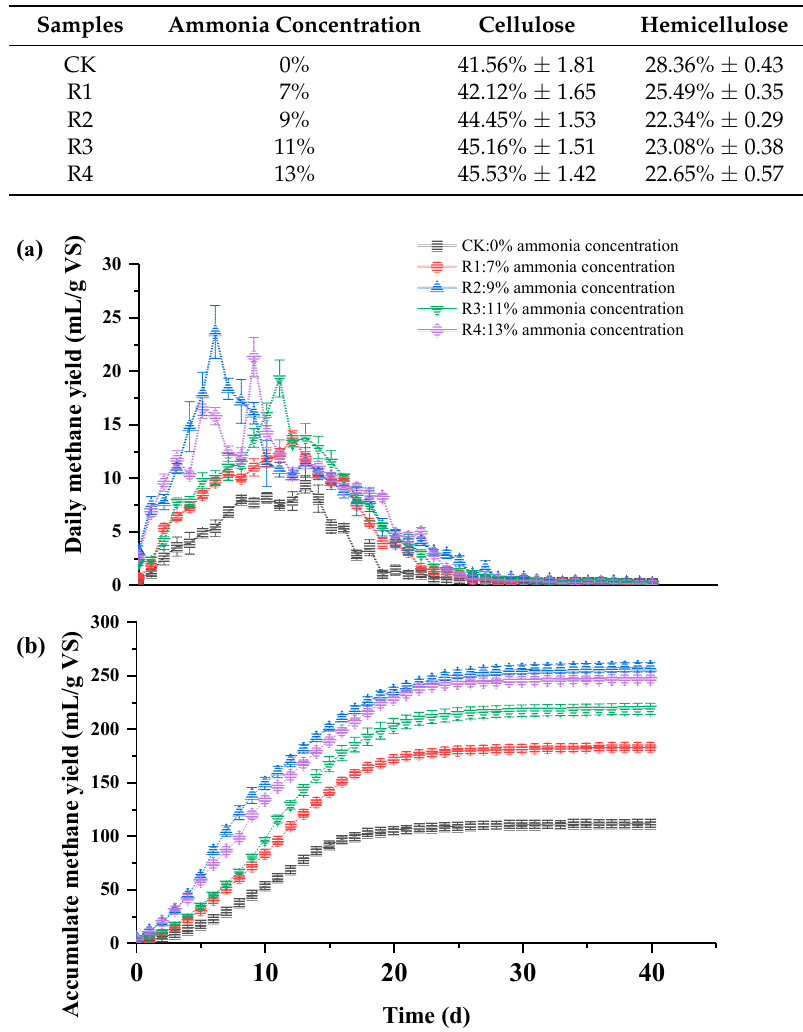
Figure 1. Changes in biogas production with different pretreatment conditions. ( a ) Daily methane yield; ( b ) Cumulative methane